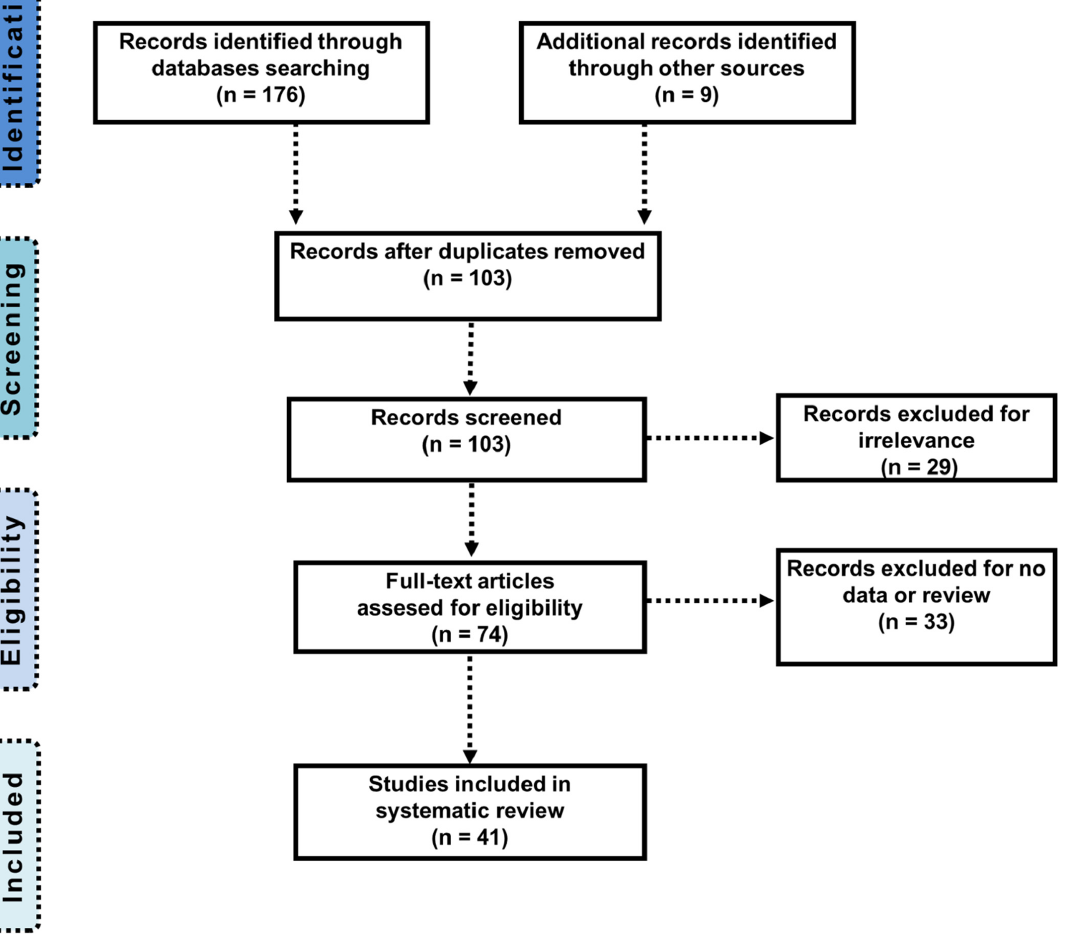
Figure 2. PRISMA flow chart presenting the articles identification and selection processes.